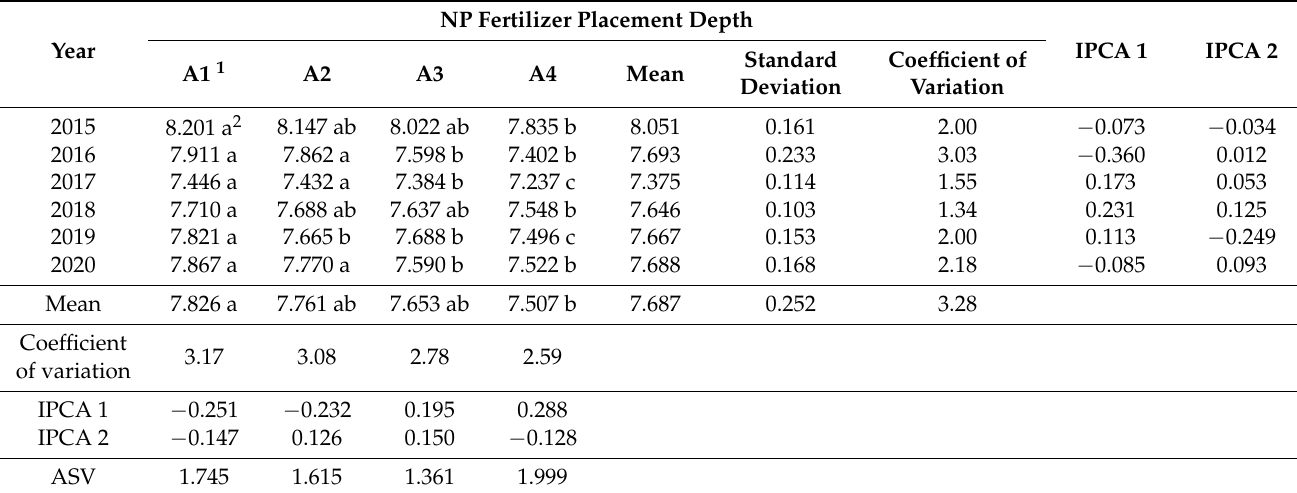
Table 4. Average number of maize ( Zea mays L.) plants after emergence (plant m − 2 ), for NP fertilizer placement depths and years, principal component analysis values (IPCAg1, IPCAg2) and AMMI stability value (ASV).